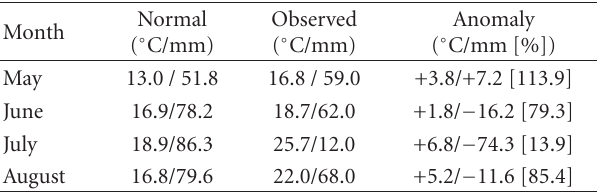
Table 1: The temperature ( ◦ C) and precipitation (mm) for May– August 2010 for the Moscow, Russia. In the right column, the precipitation anomaly is expressed as a % of